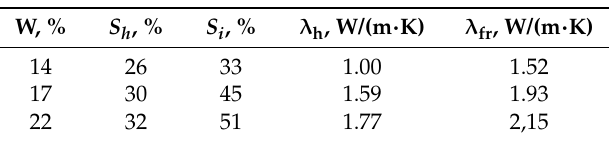
Table 4. Joint effect of hydrate and ice saturation on thermal conductivity of frozen silty sand samples with Kh ≈ 0.3 at t = − 6 ± 1 °C and P = 0.1 MPa.